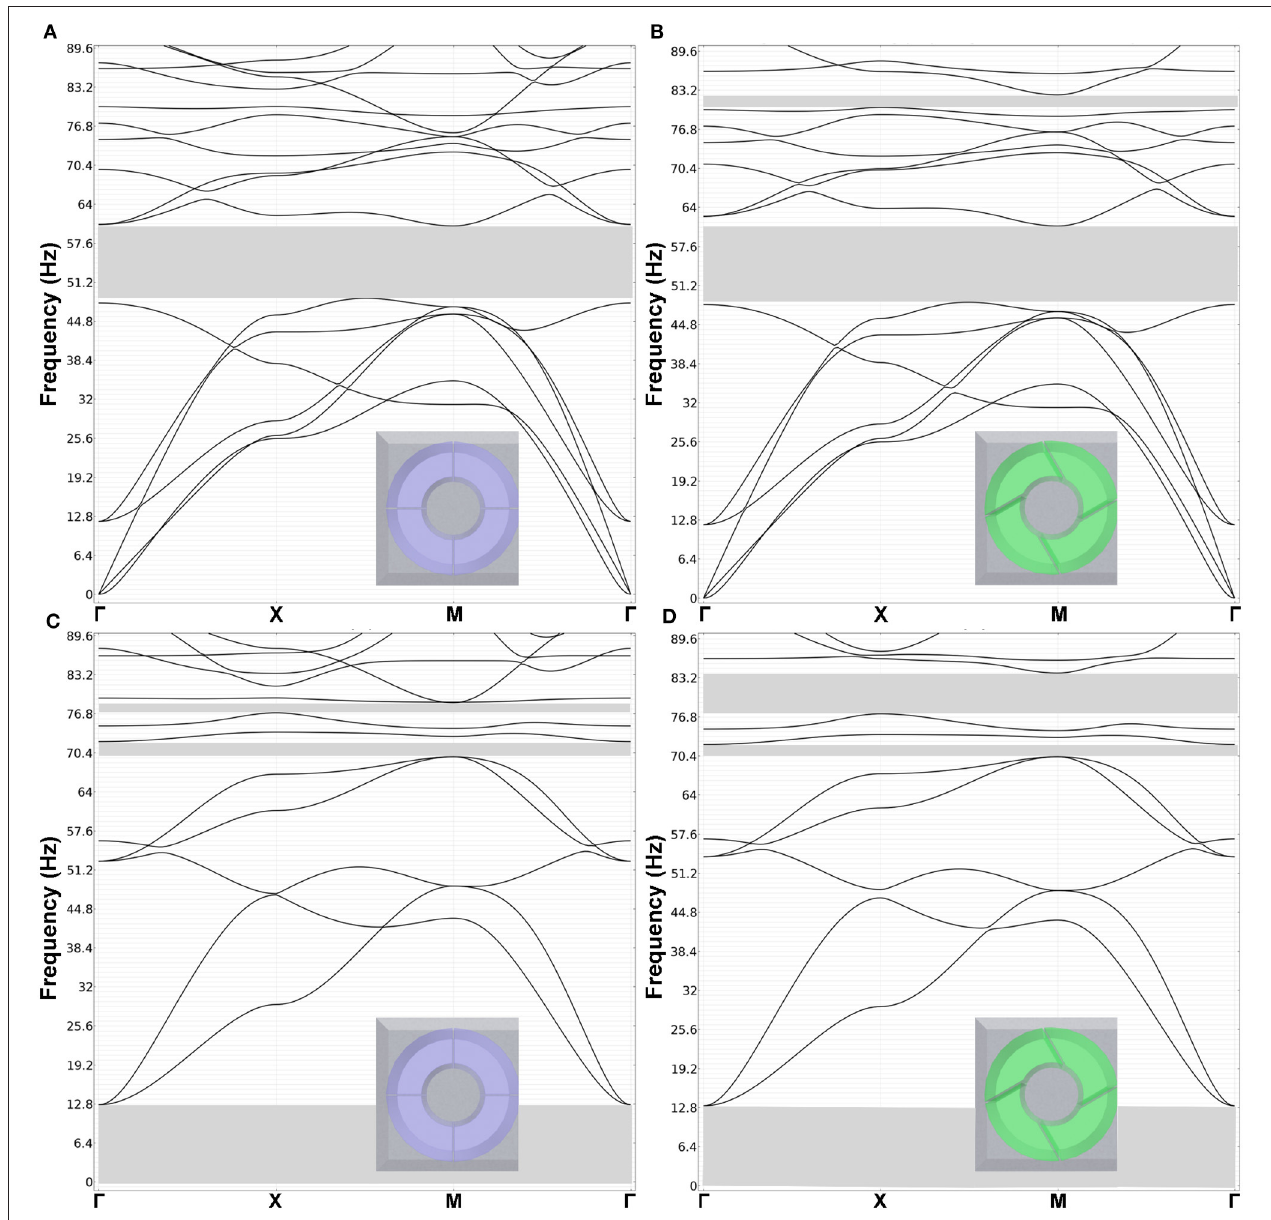
FIGURE 1 | Floquet-Bloch band diagrams for cylindrical inclusions obtained for a modulus of Bloch wavevector | k | , see (2), that describes the edges of the irreducible Brillouin zone Ŵ XM . Note that there is an enhanced bandgap range for inclusion with four aligned ligaments (A) in comparison to cylindrical inclusion with inclined ligaments (B) : the bandgap width is ∼ 12 Hz for the former and 15 Hz for the latter, in accordance with earlier study on 2D inertial resonators (Bigoni et al., 2013). Note also that a new gap is opening around 80 Hz. However, when we clamp the inertial resonators in (A,B) to the bottom of the plate (that could be a model for a bedrock), in (C,D) , respectively, we note some zero frequency stopbands occur between 0 and 12.8 Hz, and the first three bands in (A) , (B) do not appear in (C,D) . This is the clamping effect already observed in Achaoui et al. (2017). Importantly, the rotational modes occur at frequencies below the first stopband (see